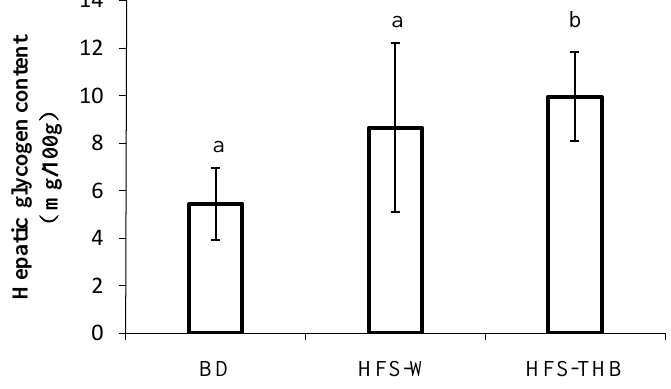
Figure 3. Hepatic glycogen in rats at the end of the 15-week study. Samples were analyzed using a one-way ANOVA followed by a Turkey post doc test. Evaluations were taken among three groups, a, b indicate statistical differences ( P < 0.05), the same letters indicate no statistical differences ( P > 0.05).